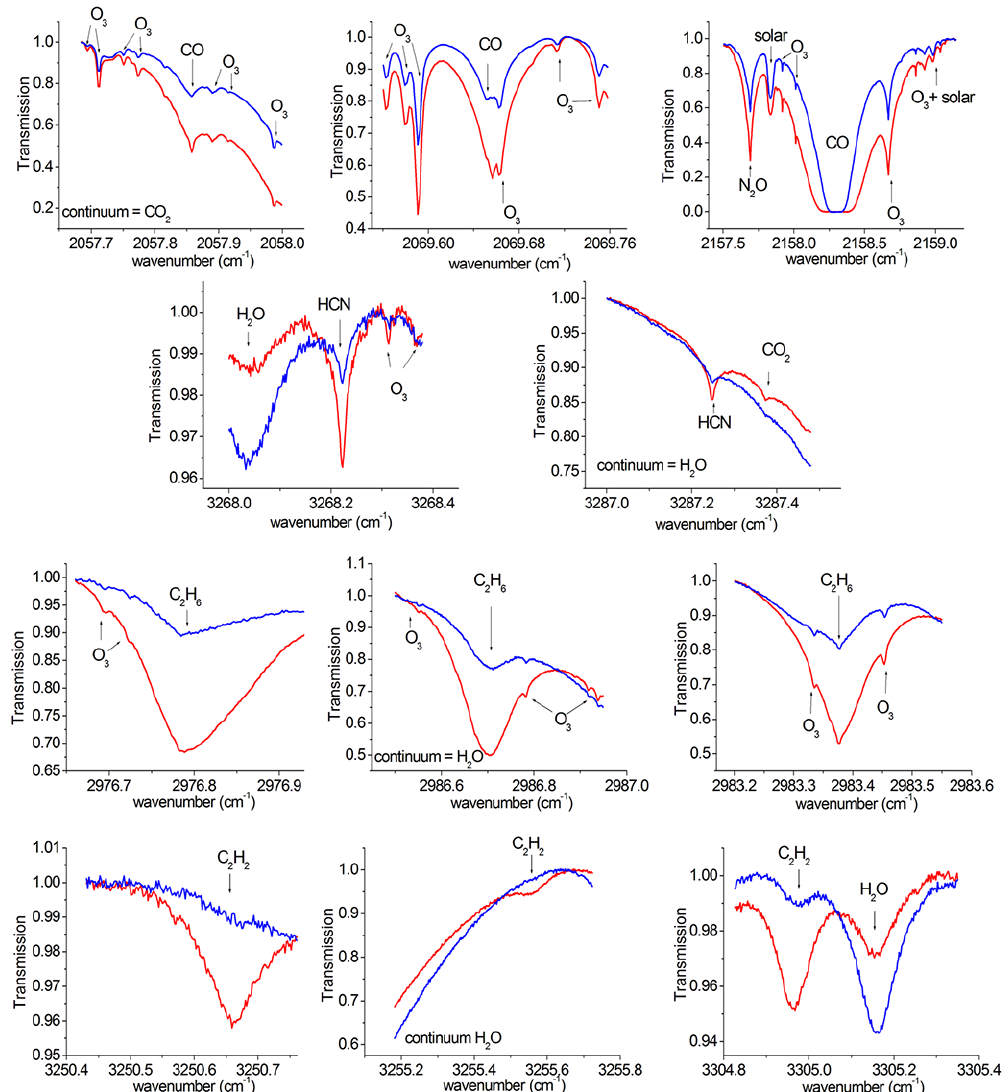
Figure 1. Microwindows used in the retrievals of CO, HCN, C 2 H 6 and C 2 H 2 , with examples of clear and polluted conditions in blue and red,